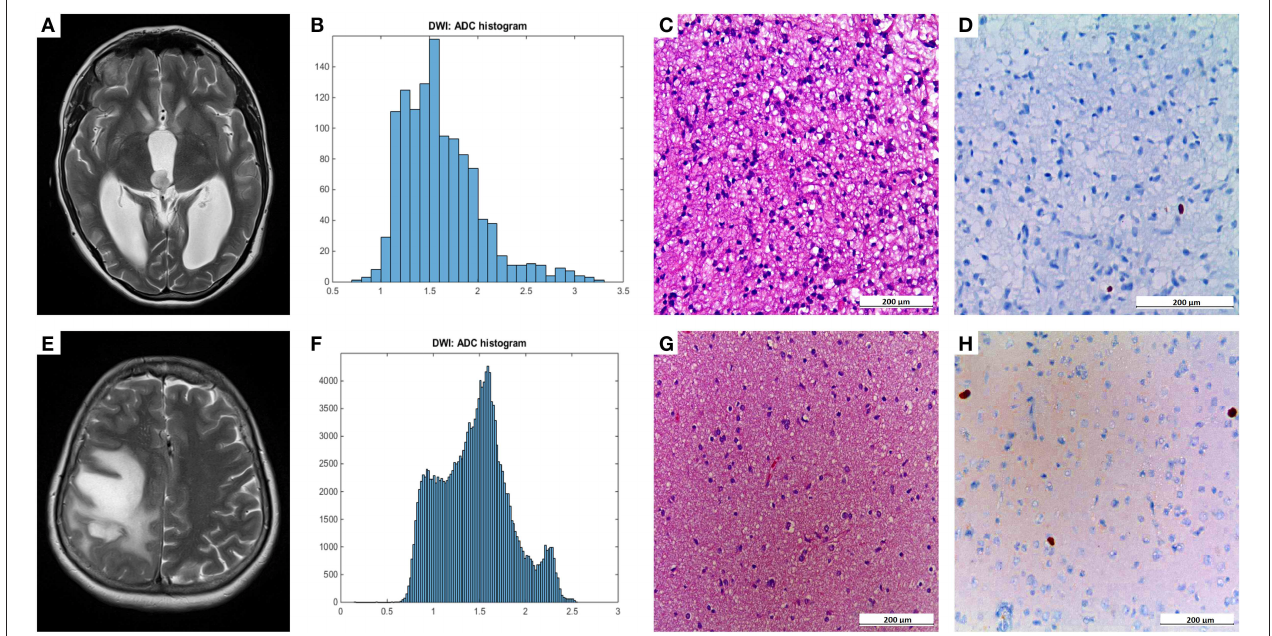
FIGURE 1 | Compares representative MRI sections, the corresponding whole tumor ADC histogram, H&E staining, and Ki-67 immunohistochemistry of a grade I (A–D) and a grade II glioma (E–H) . The first image of the upper case shows a T2 weighted turbo-spin-echo (TSE) sequence of a grade I glioma, originating from the right thalamus with intraventricular tumor mass in the third ventricle and consecutive hydrocephalus (A) . The first image of the lower case displays a T2 weighted TSE sequence of a grade II diffuse astrocytoma located in the right frontal and parietal lobe with distinct mass effect (E) . The second images of each row show the ADC